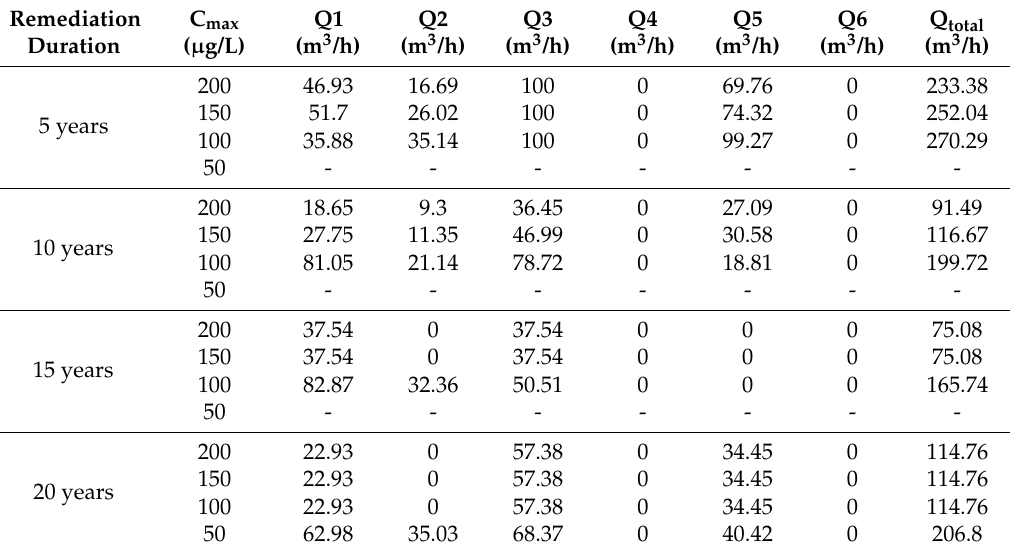
Table 1. The remediation strategies under different scenarios while ELCR max at